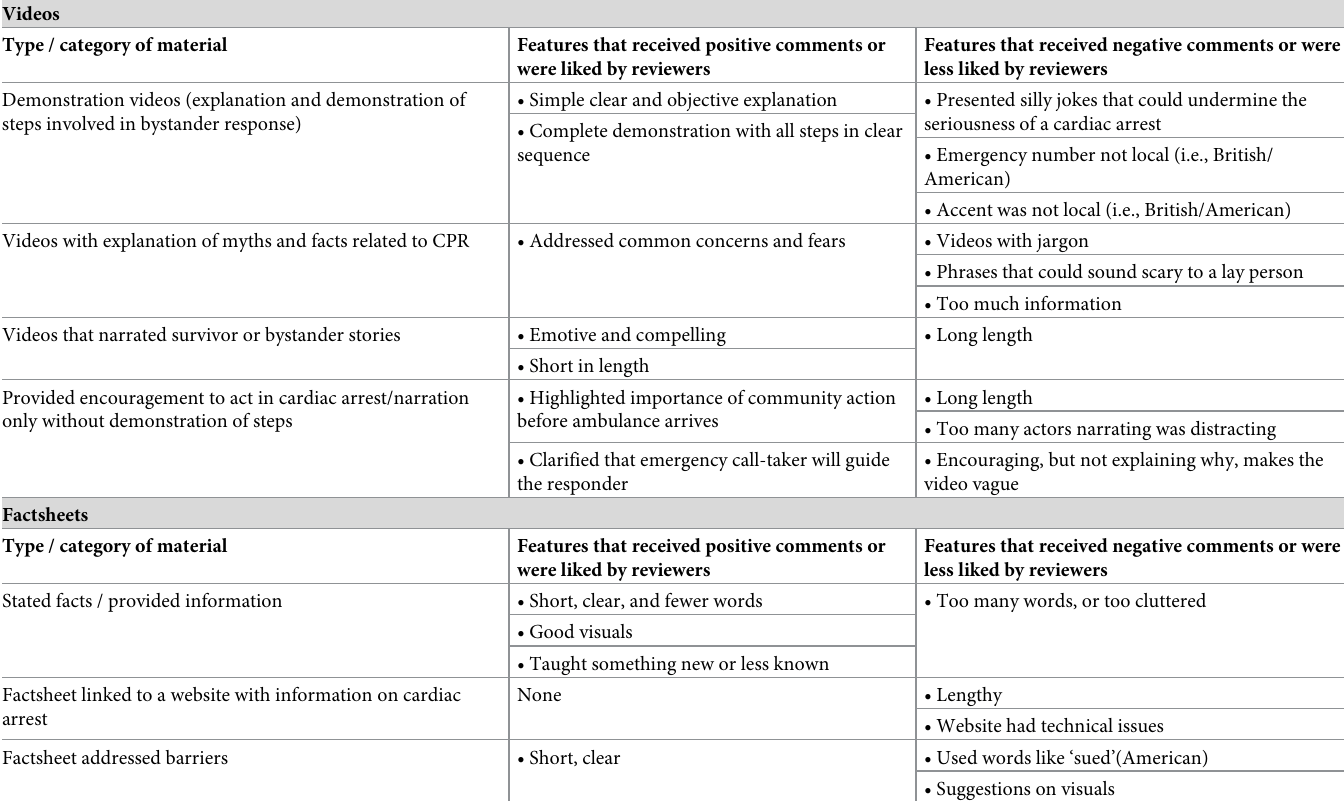
Table 1. Summary of feedback on videos and